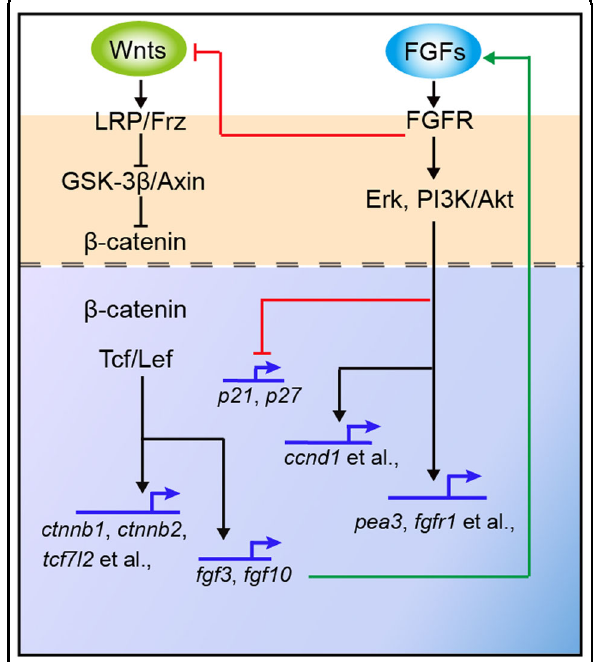
Fig. 7 A simple model of how the Wnt and FGF signaling pathways control cell proliferation in the zebra fi sh neuromast. Red lines show inhibition, and green lines indicate